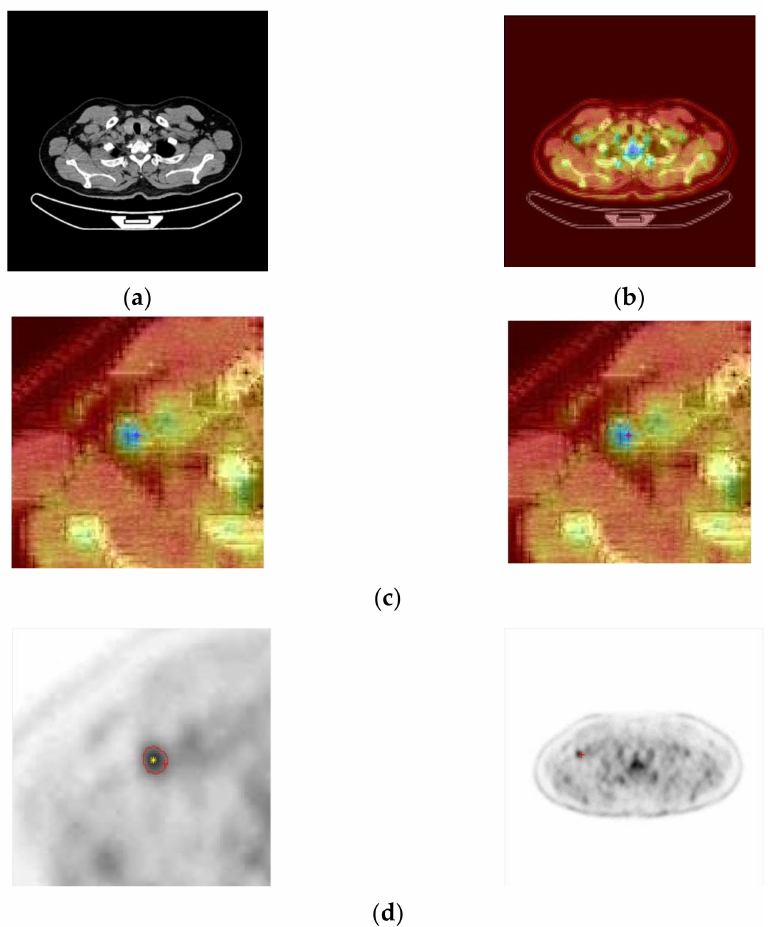
Figure 6. Example of intelligent labeling. ( a ) The original CT image. ( b ) The PET image is fused with the CT image. ( c ) The red “+” symbol on the pseudo color PET and CT fusion image after click. ( d ) The corresponding * symbol appears on the enhanced